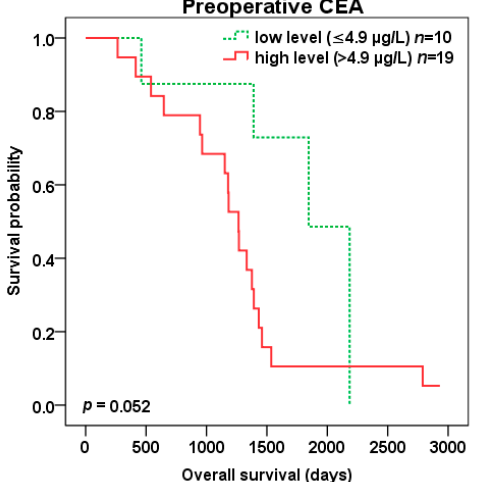
Figure 7. Overall survival (OS) after liver surgery for patients with low (green color dotted line) vs. high (red color) preoperative CEA level (cut-off 4.9 µg/L).